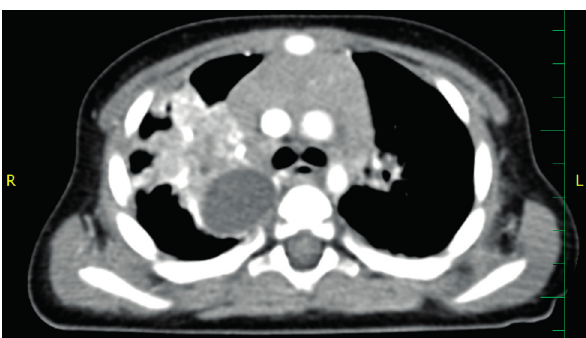
Fig. 4. The axial contrast CT scan demonstrates a foregut mal- formation, esophageal cyst, in the right hemithorax. was observed in the medial wall of the right upper